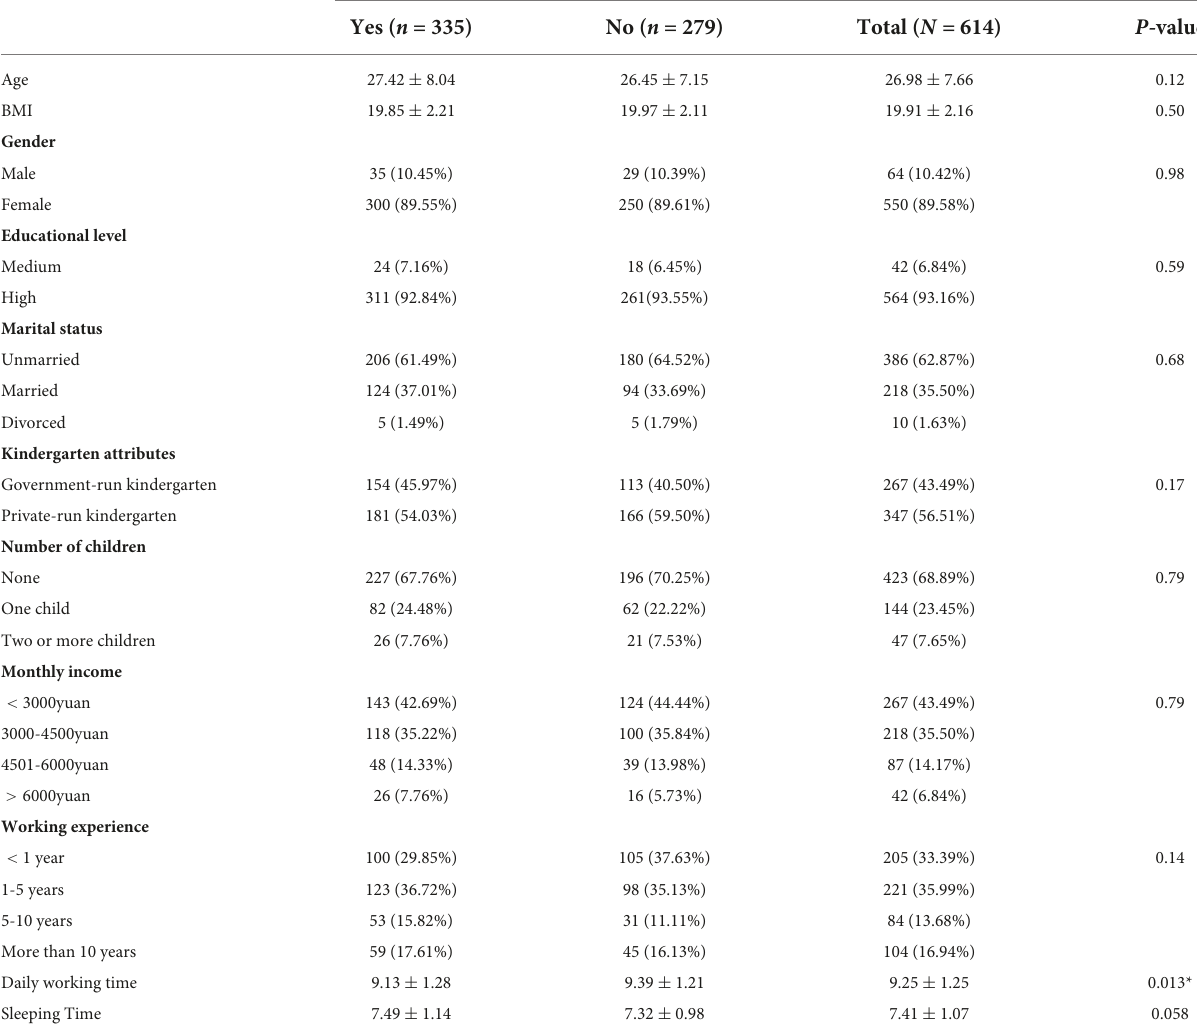
TABLE 1 General characteristics information of the